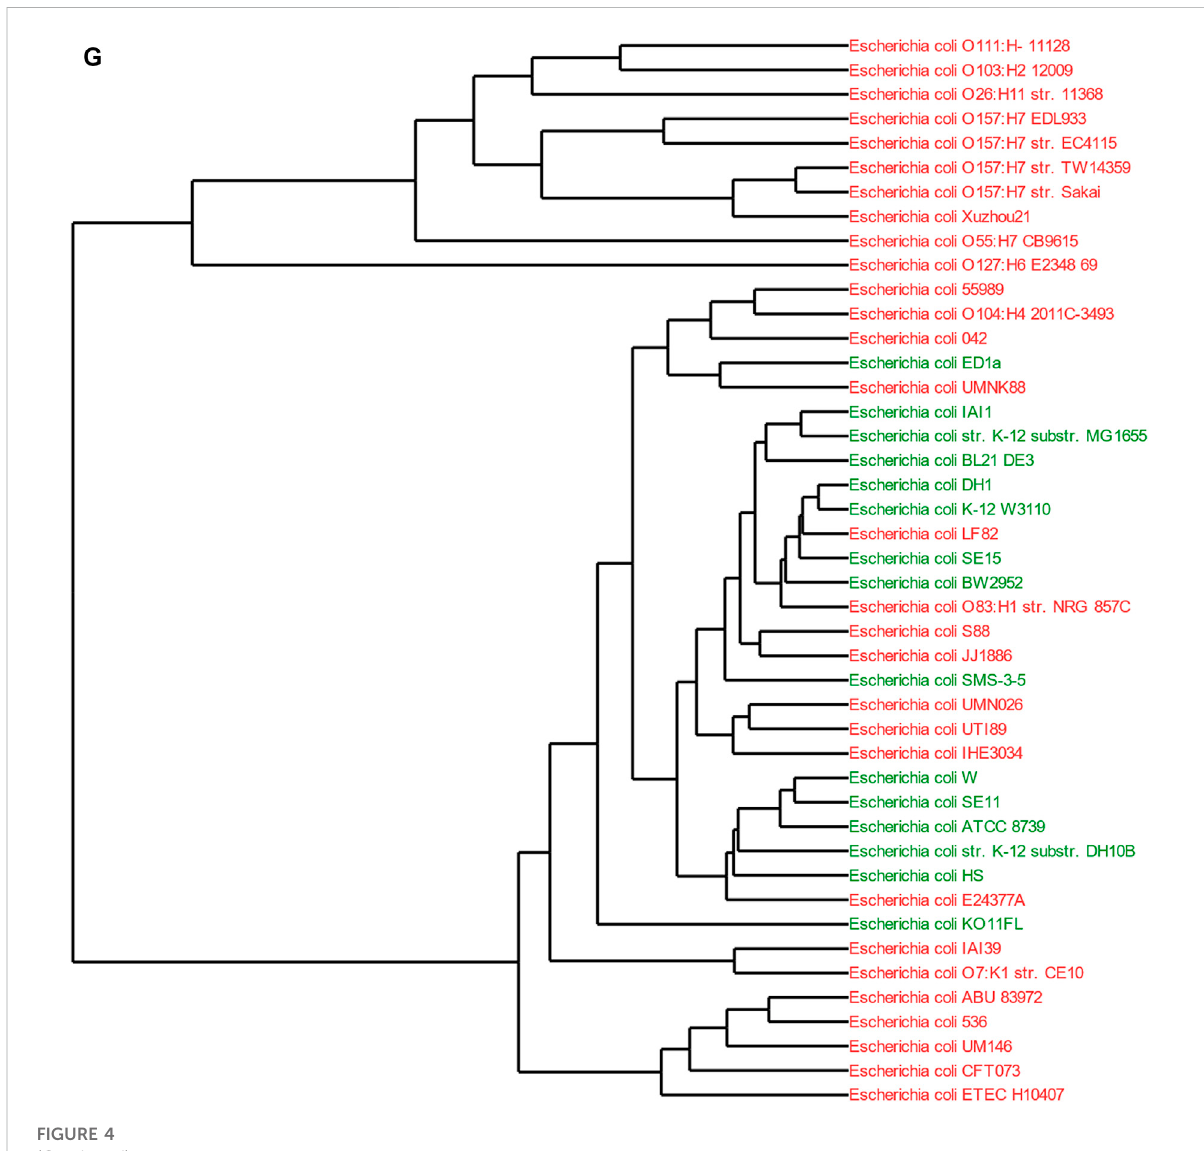
Figure 4G colors and labels the dendrogram based on pathogenic and non-pathogenic strains, whereas Supplementary Figure S1 colors by pathogenic and non-pathogenic group). Since infections caused from intestinal pathogenic E. coli (IPEC) are distinct from infections caused extraintestinal pathogenic E. coli (ExPEC, including uropathogenic E. coli ) (Kohler and Dobrindt, 2011), we separated with E. coli pathogenic strains into IPEC strains — including a group of enterohaemorrhagic E.